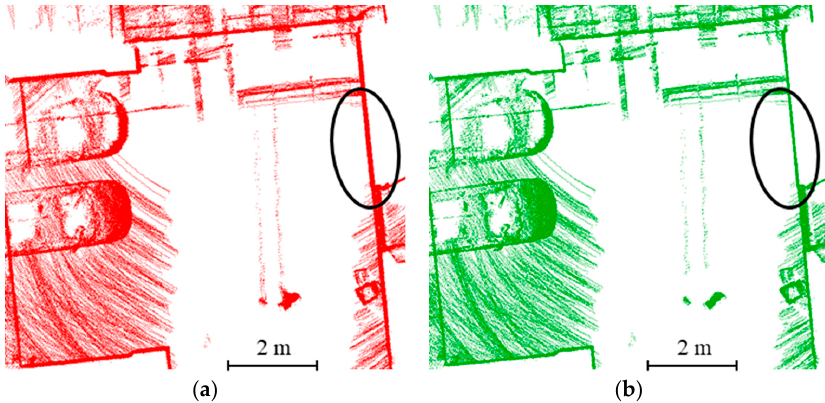
Figure 2. An example of point-to-plane iterative closest point (ICP) sequential registration result. ( a ) The raw point cloud generated by the Cartographer algorithm. ( b ) The local optimized point cloud after sequential registration. This scene is one of five scenes selected from datasets in the test that decides the algorithm and the values of parameters used for sequential